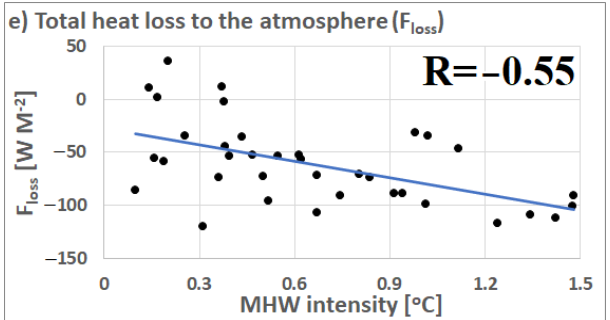
Figure 11. Scatter plots of marine heat wave intensity during the study case 1 (10 July 2001 to 22 August 2001) and surface latent heat flux ( a ), surface sensible heat flux ( b ), surface net thermal radiation ( c ), surface net solar radiation ( d ), and total heat loss to the atmosphere ( e ).